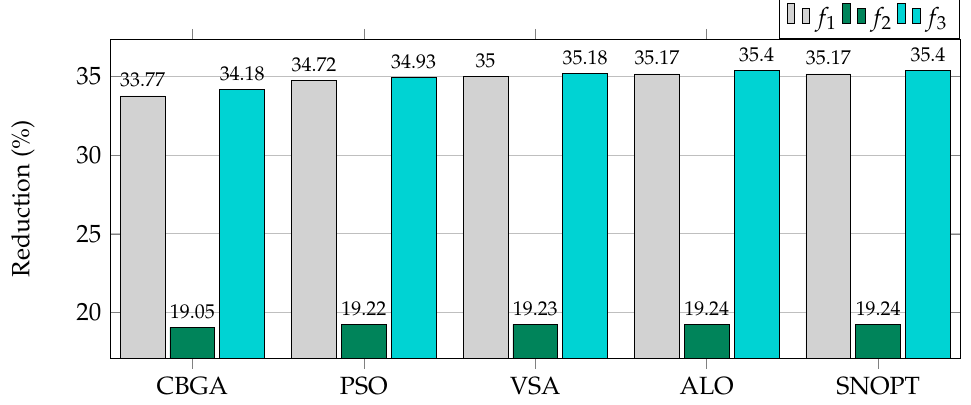
Figure 8. Reduction percentage regarding the objective functions in the IEEE 27-bus